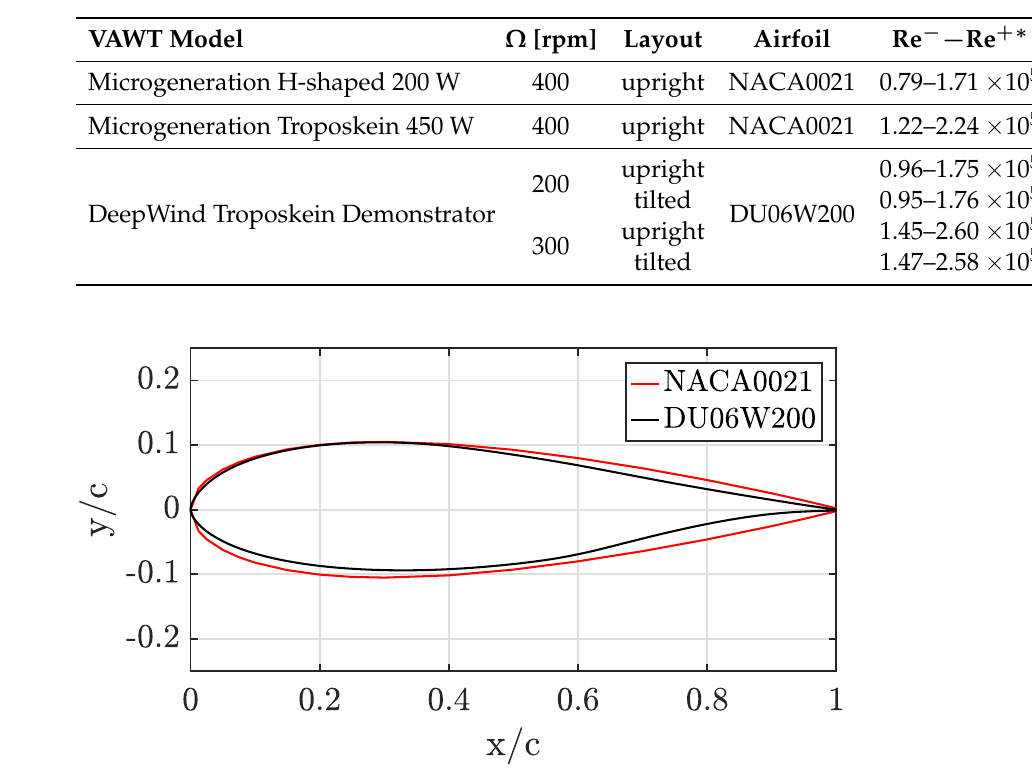
Table 4. List of cases for experimental validation. (*) Maximum and minimum Reynolds numbers are referred to optimal TSRs, at equatorial plane.